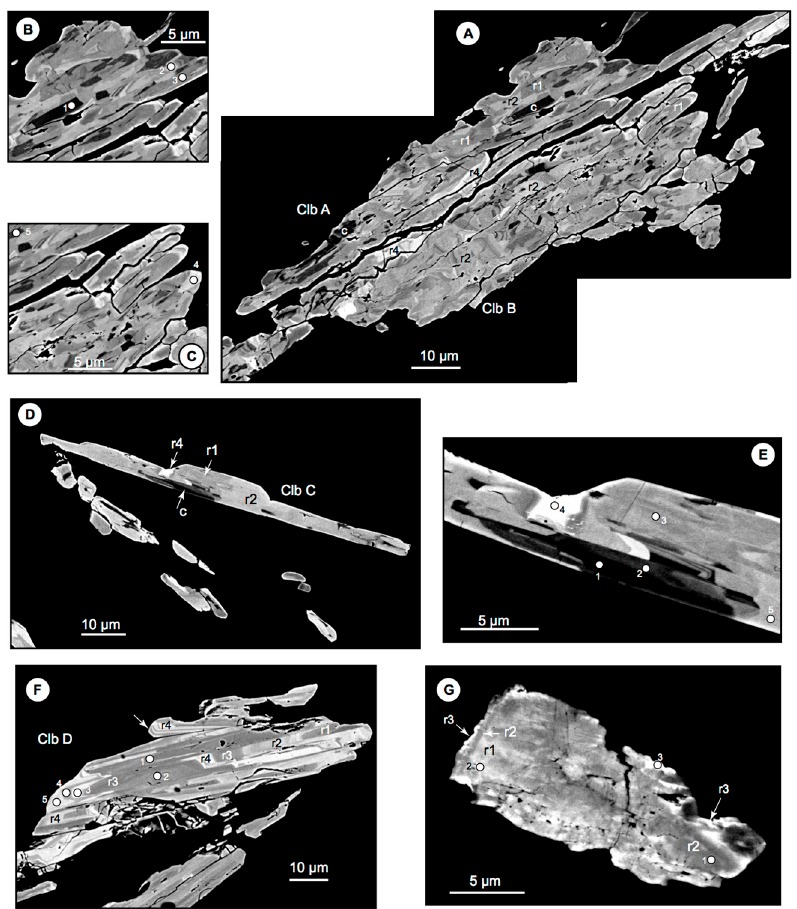
Figure 16. SEM-BSE images of the columbite-tantalite (Clb) from the G2 and G3 granite units: c core, r1 to r4 rims (see text). ( A – F ) G2 unit (sample PAN-16-8). ( A ) Two adjoined prisms: Clb A with numerous prismatic dark core sections and the almost full replacement of r1 by r2; by contrast, Clb B is devoid of dark cores, but with the aggregation of r2-r3 sub-units. ( B , C ) details of ( A ), showing the position of analyzed spots (Table S3). ( D ) Acicular Clb prism, displaying replacement of r1 by r2. Note the absence of r3. ( E ) Detail of ( D ), showing the emplacement of analyzed spots. ( F ) Blocky Clb prism with spectacular OZ in r2 and r4 and up to three alternating clear / dark zones in r4 (arrow). The r1 to r4 succession is seen in one of the aggregated prisms. The location of the analyzed spots is indicated. ( G ) Columbite-tantalite from the aplite unit (sample PAN-16-9); r1 to r3 is the proposed succession order. The location of the analyzed spots is shown.